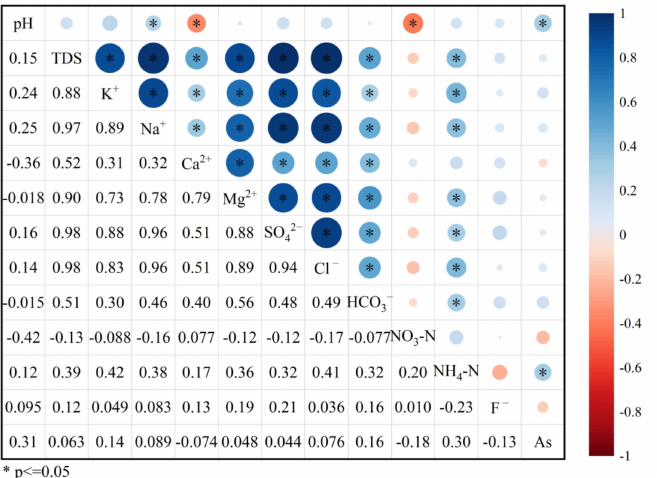
Figure 6. Correlation coefficient diagram of the groundwater hydrochemical